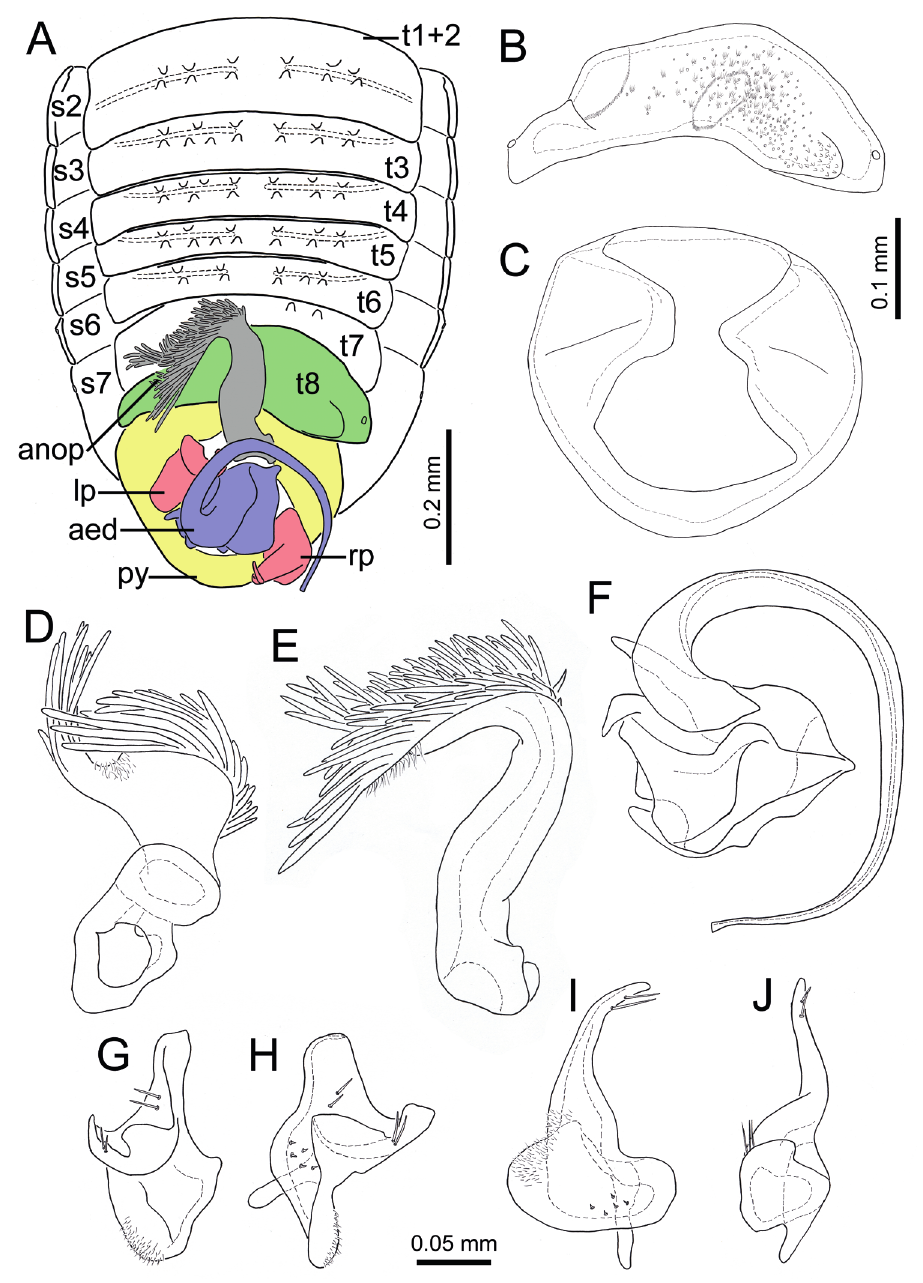
Figure 8. Drawings of Cornonannus bui gen. et sp. nov., male paratype A abdomen in dorsal view B tergite VIII in dorsal view C pygophore in dorsal view D, E two aspects of anophoric process F Aedeagus in dorsal view G–H two aspects of left paramere I, J two aspects of right paramere. Scale bars: 0.2 mm ( A ); 0.1 mm ( B, C ); 0.05 mm ( D–J